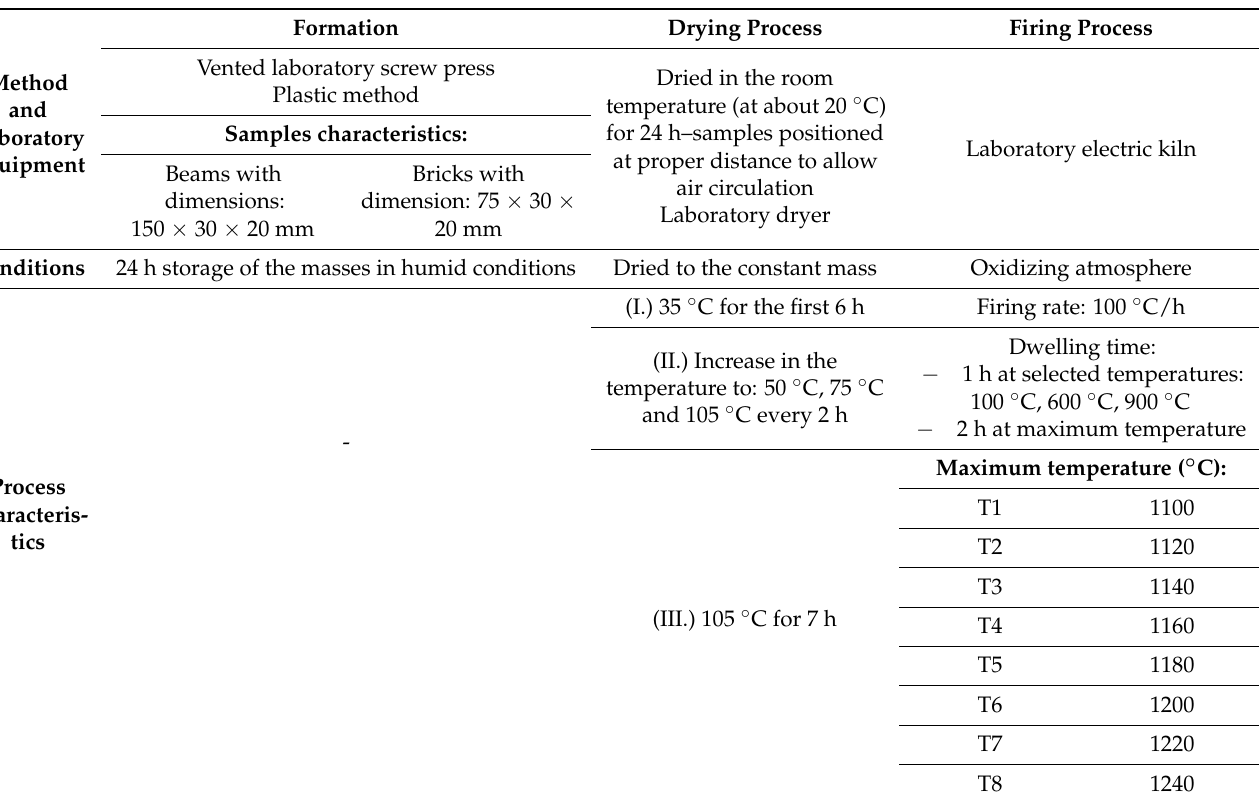
Table 2. Preparation process of experimental